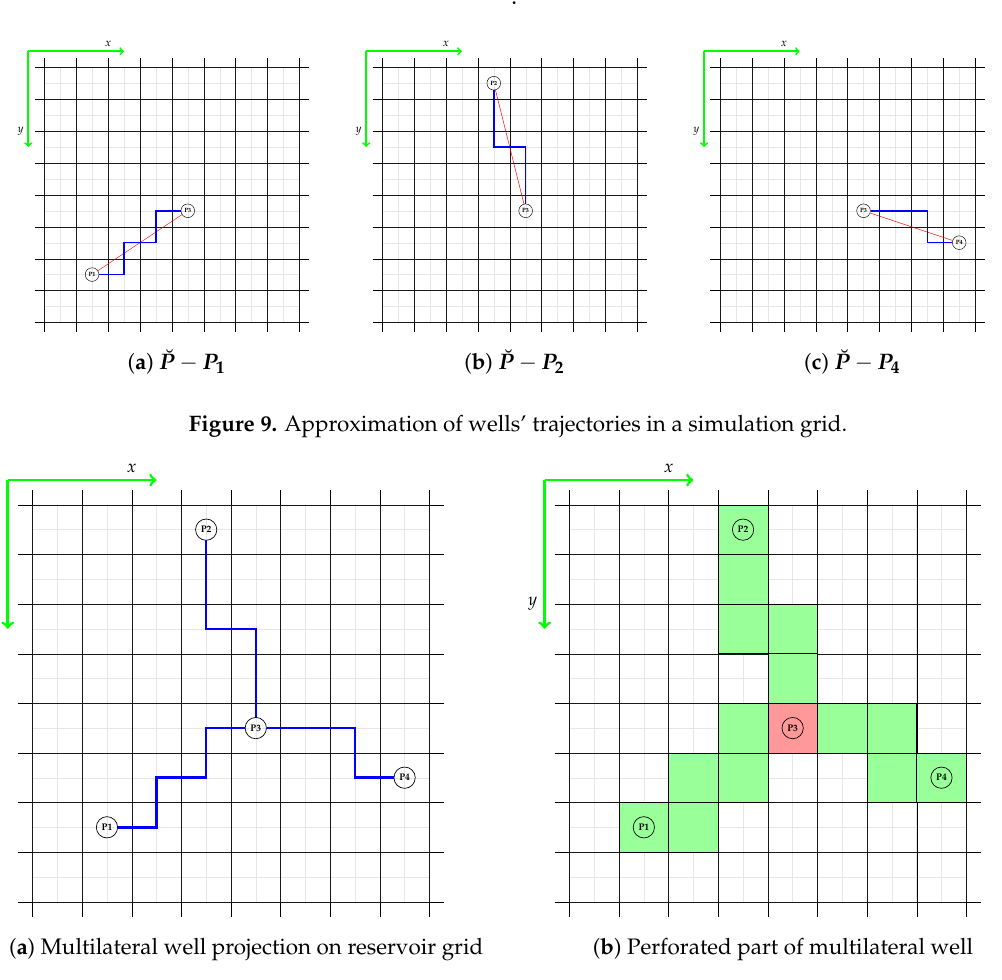
Figure 10. Projection of the multilateral well trajectory into blocks of a dynamic model, viewed in the plane of the well